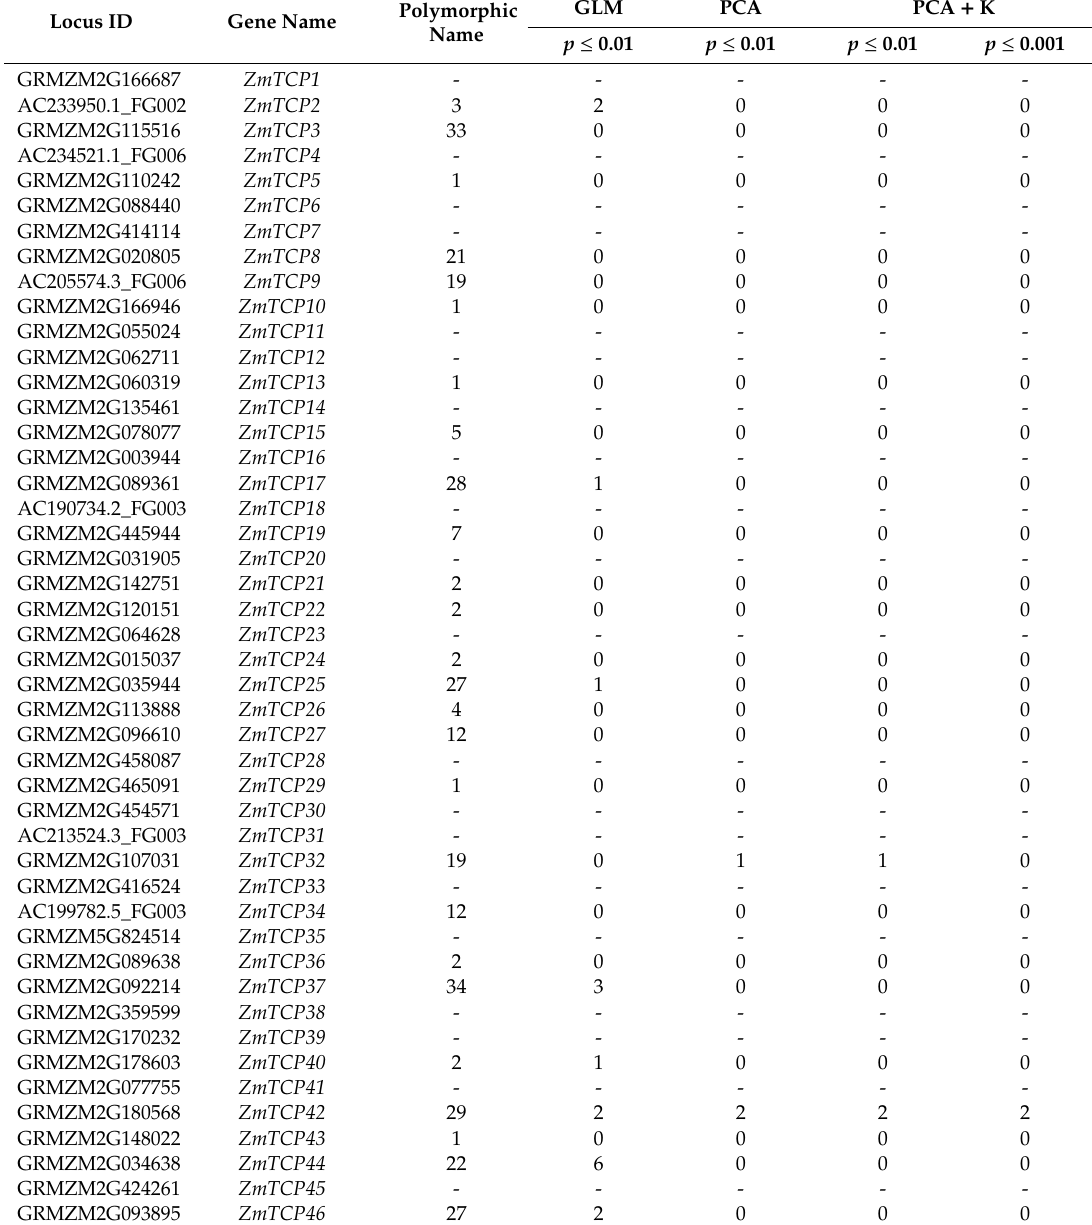
Table 2. Association analysis of the natural variation in ZmTCP genes with respect to drought tolerance at the seedling stage in the maize diversity